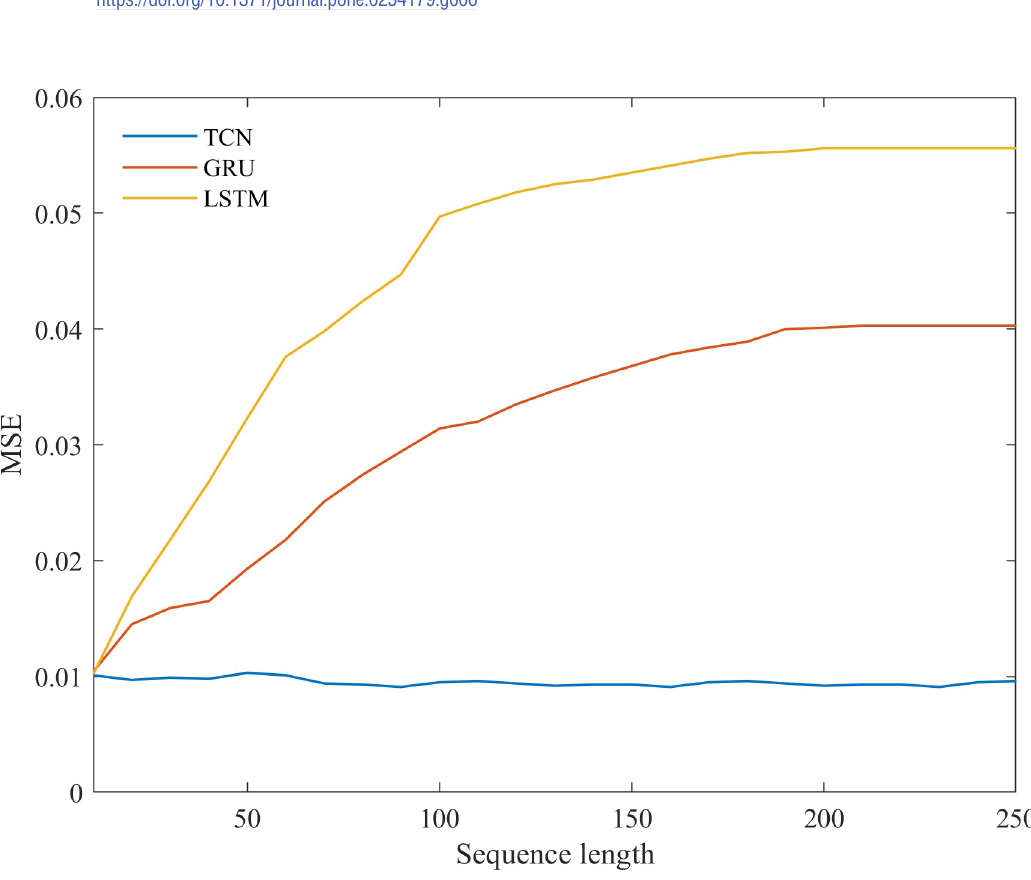
Fig 7. Performance of three models in sequences of different lengths.